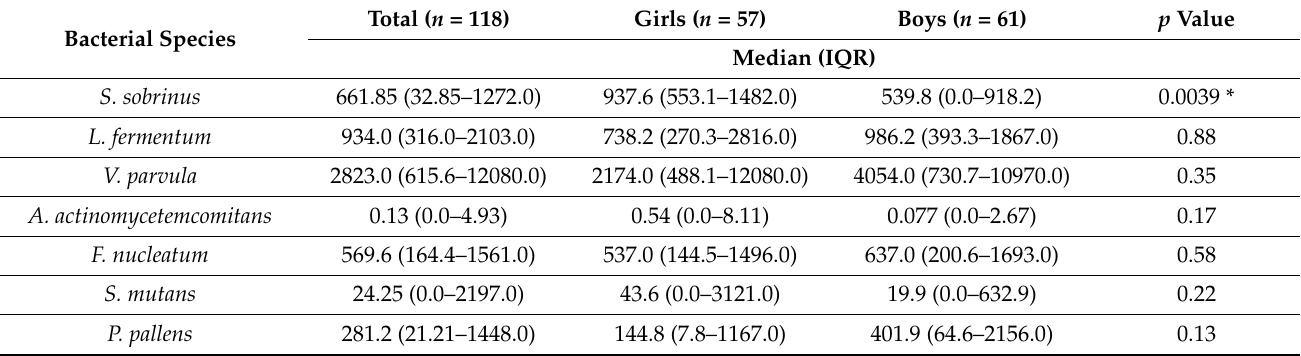
Figure 2. The relative abundance of species genes in the tested children from saliva samples presented on the heat map. Table 2. Relative bacterial abundance of saliva samples in relation to gender in saliva